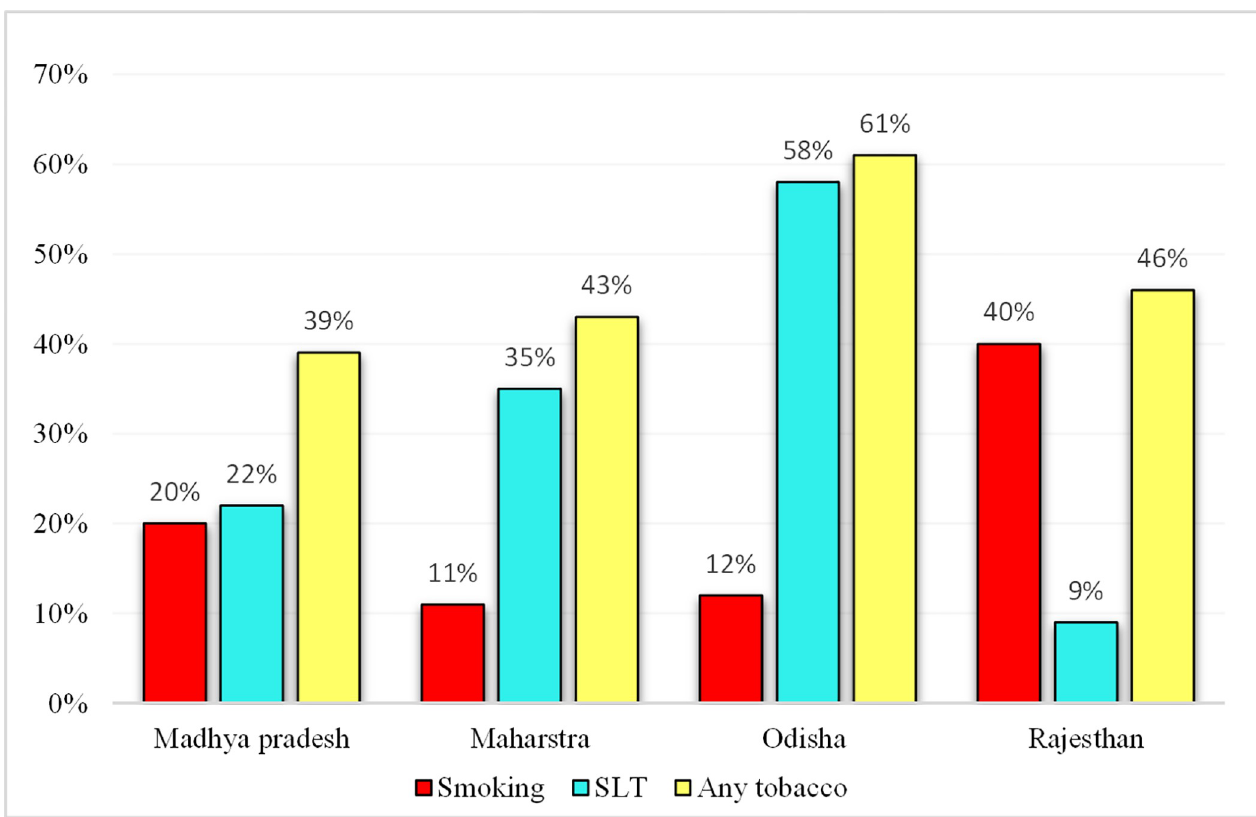
Fig 3. Prevalence of different forms of tobacco use across major tribal populated states.